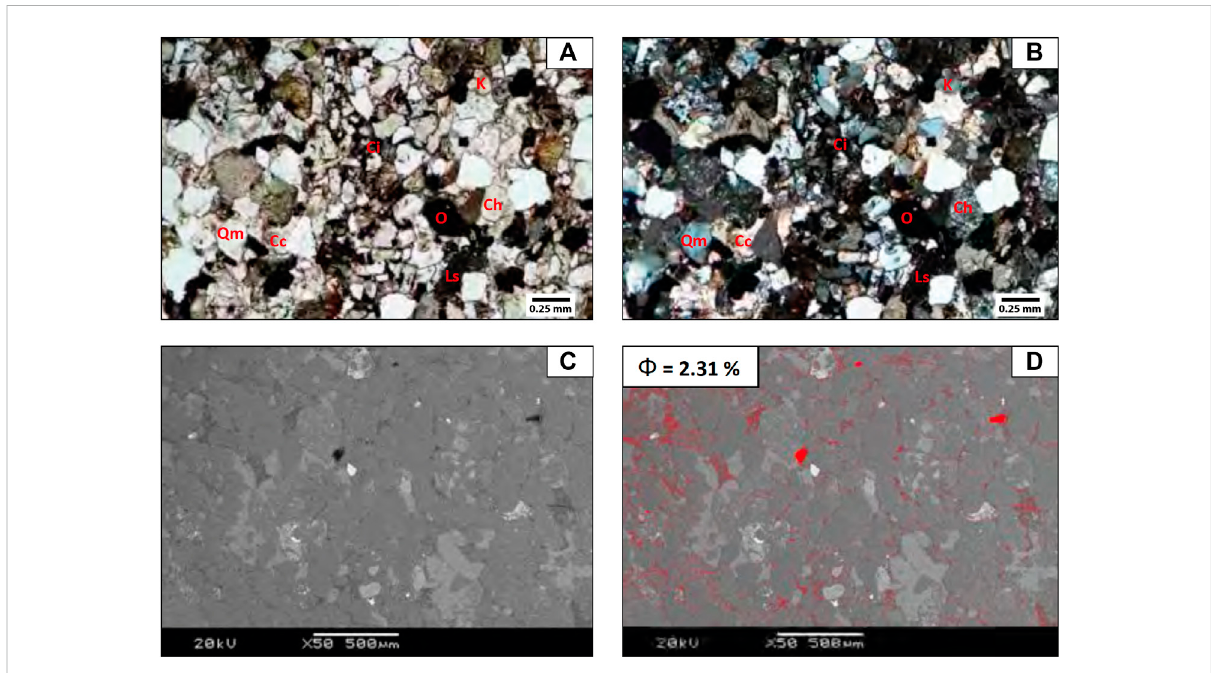
FIGURE 10 Photomicrographs of outcrop study from the Nam Phong sandstones (the base of the Khorat Group) in plane-polarized light (A) and in cross- polar (B) . Note: K is potassium feldspar, Ci is iron oxide cement, Ch is chert, O is opaque mineral, Ls is sedimentary lithic fragments, Qm is monocrystalline quartz, and Cc is calcite. The backscattered electron image of the Nam Phong sandstones shows thresholding to binary image of pore space (C) . Red marks cover pore space during thresholding operation for porosity analysis (D) . These images are modi fi ed from Suteerapongpan